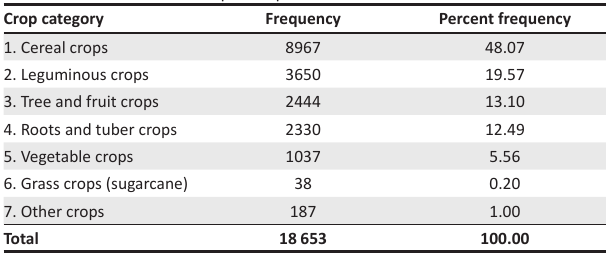
TABLE 6: Classification of crop enterprises.